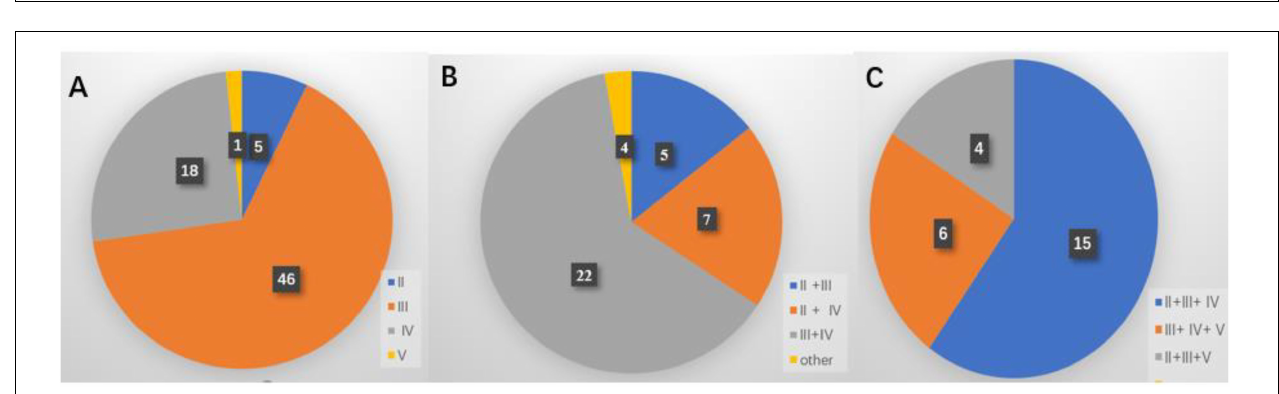
FIGURE 2 | Patterns of metastasis. (A) According to the classification of the lateral neck dissection level. (B) According to the number of levels involved.